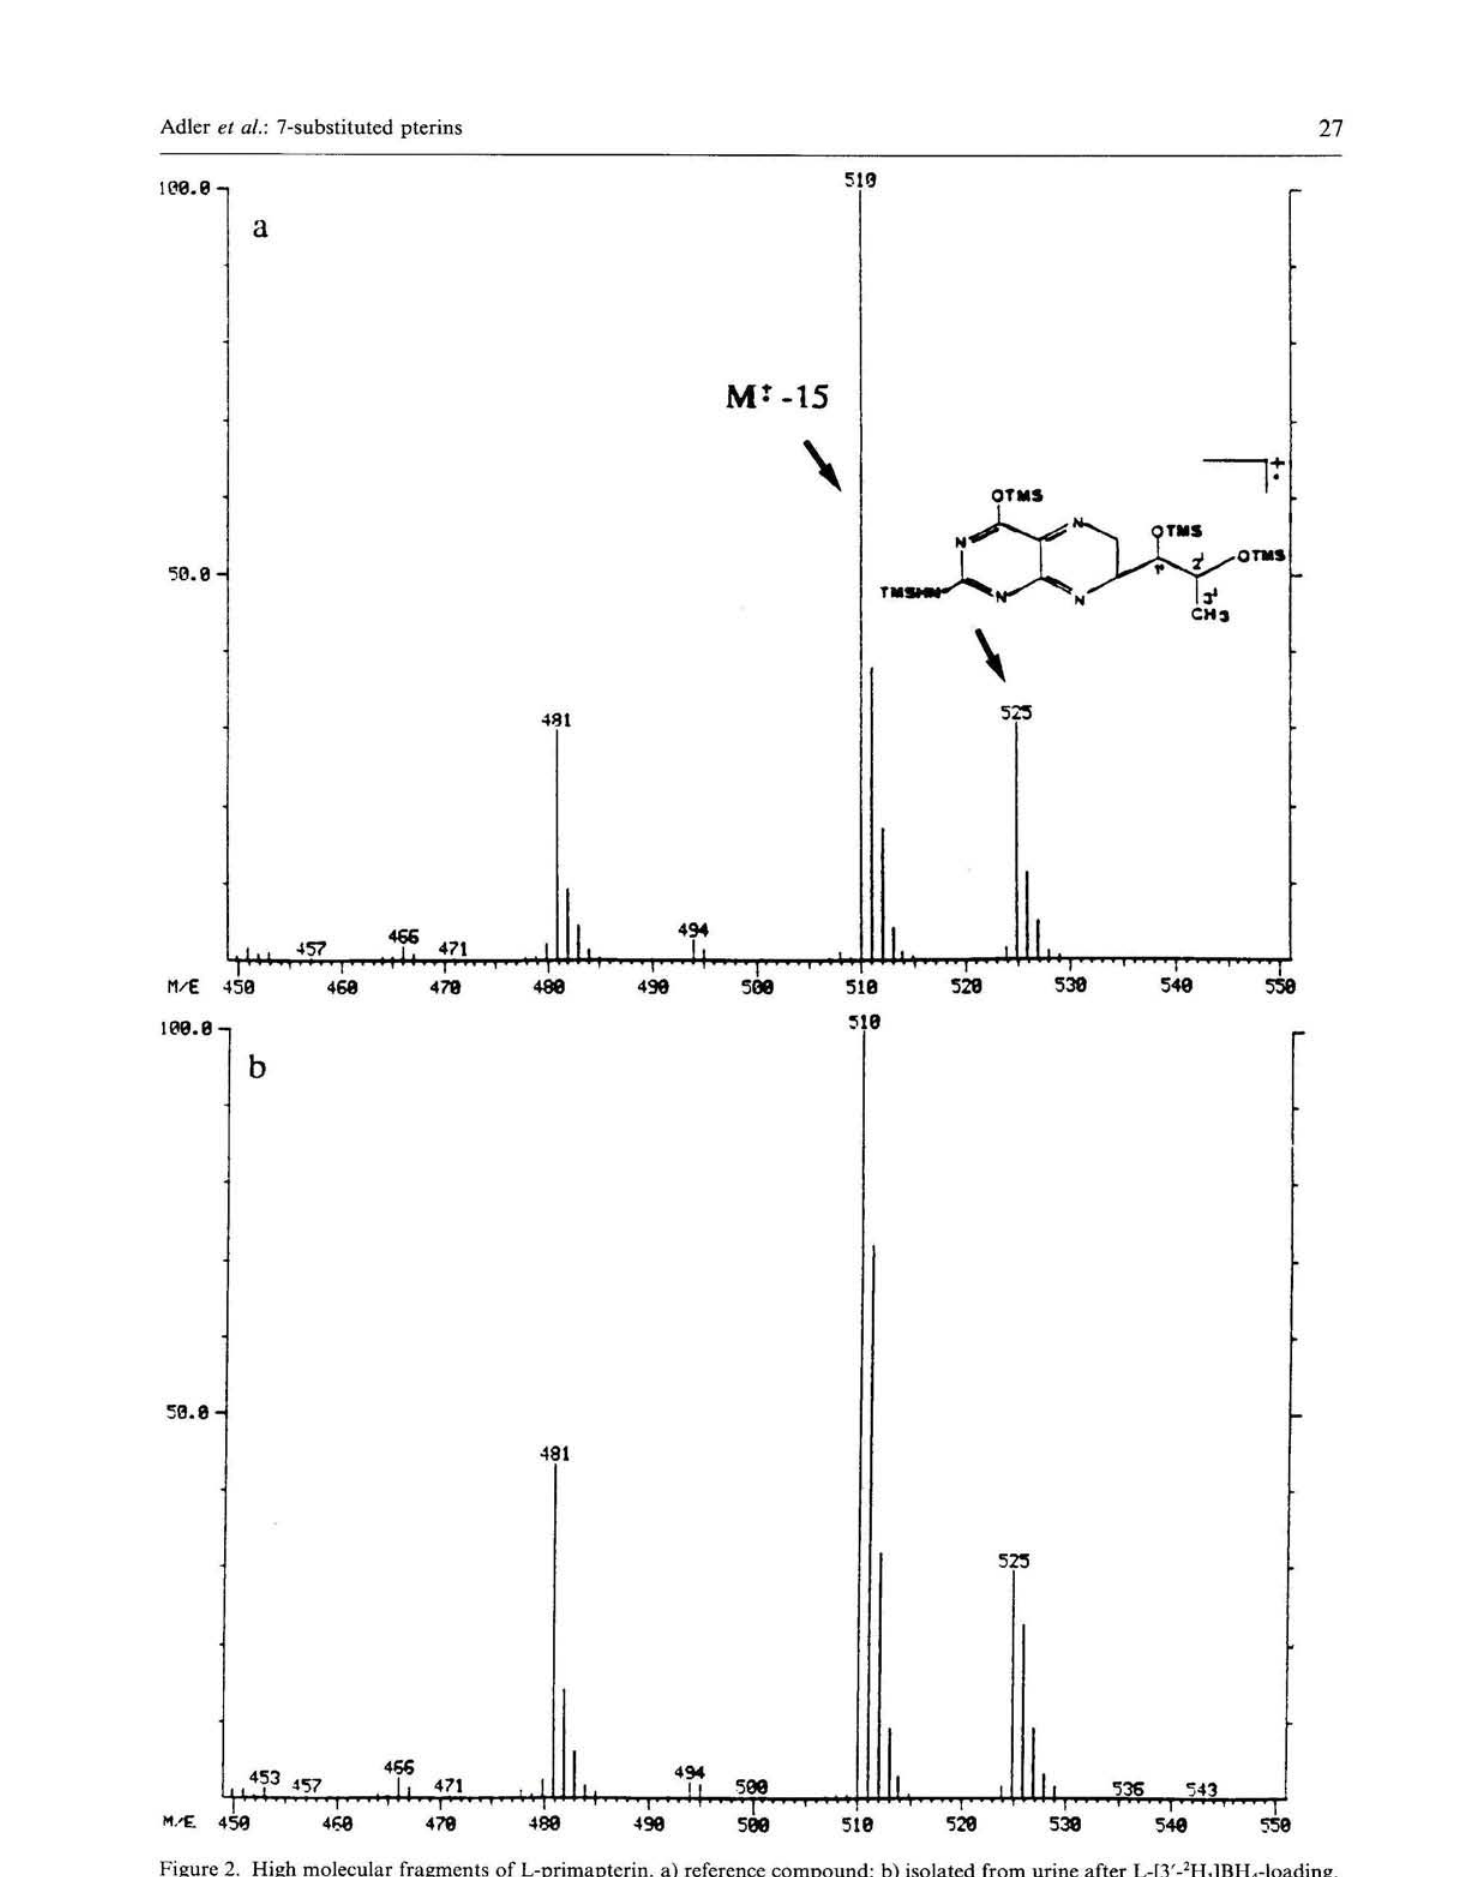
Figure 2. High molecular fragments of L-primapterin. a) reference compound; b) isolated from urine after L-[3'- 2 H,]BH 4